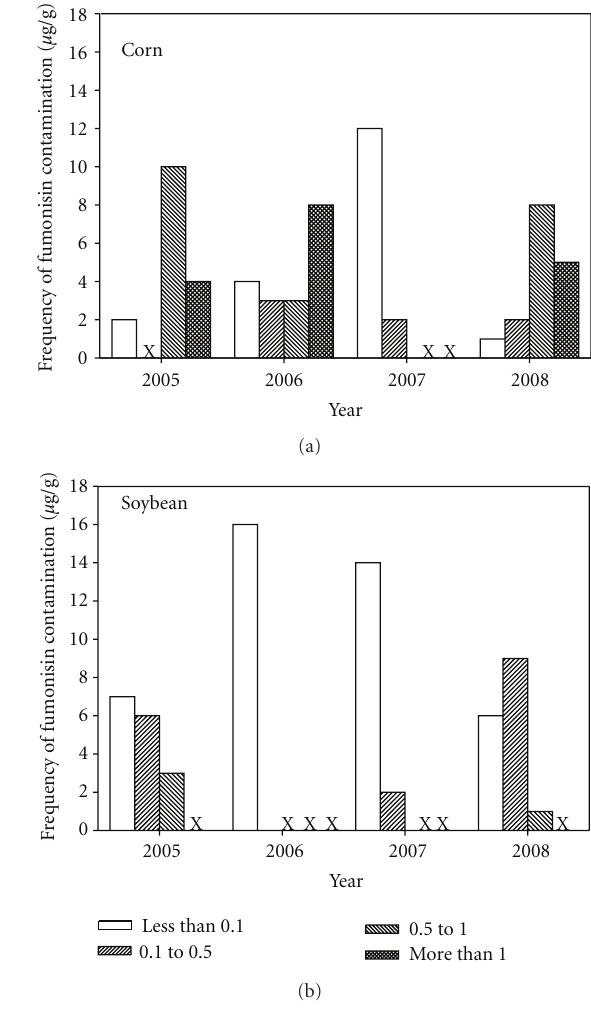
Figure 1: Frequency of aflatoxin contamination levels in corn (a) and soybean (b) in four years of field trials, each year 16 plots were planted to corn and soybean. X in the graph indicates zero frequency.